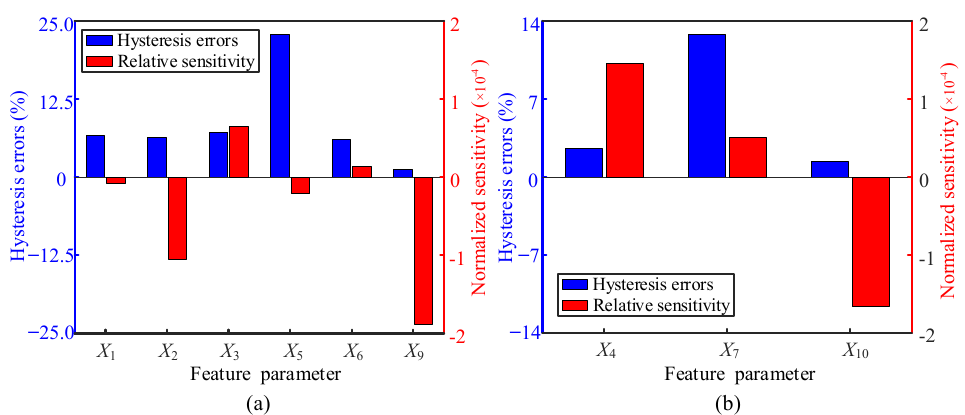
Figure 7. Estimated sensitivity of the parameters on the cable force: ( a , b ) results of the parameters belonging to parabolic and linear equations, respectively.